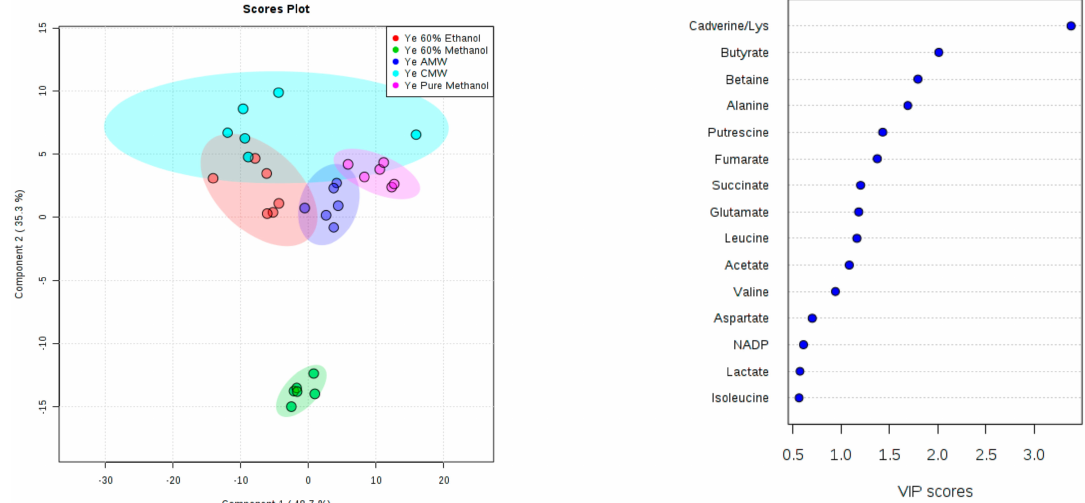
Figure 5. Partial least squares discriminant analysis (PLS-DA) score plot ( left ) and variable importance in projection (VIP) score plot derived from PLS-DA analysis ( right ) based on 36 identified compound peak areas of the polar fraction of the metabolome of Y. enterocolitica for different extraction methods: 60% methanol, PM, 60% ETH, AMW; 2:2:1, and CMW; 2:1:1. Lys: lysine.